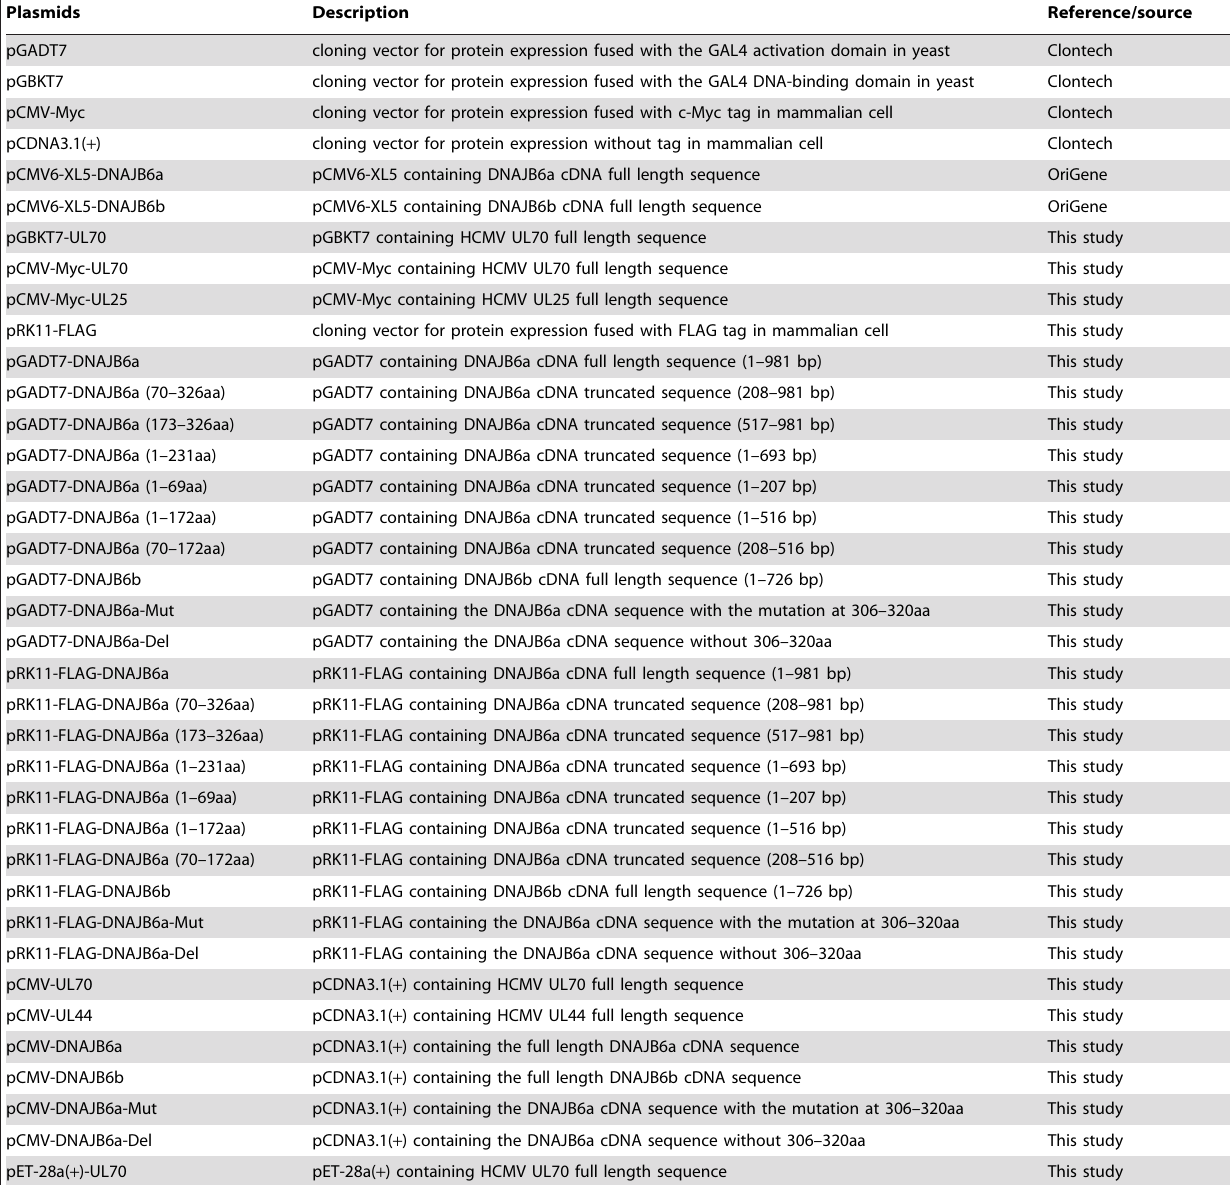
Table 1. Plasmid constructs used in the study.